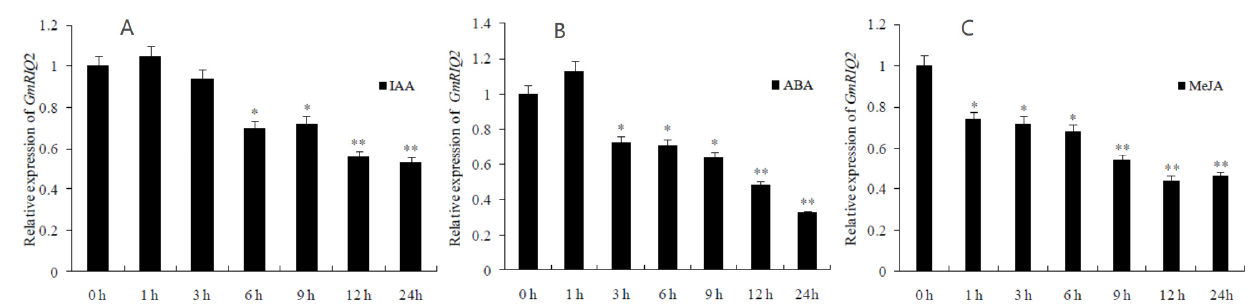
Figure 10. Determination of GUS activity of the transformed GmRIQ2 promoter ( PGmRIQ2 ) in Ara ‐ bidopsis under abiotic stress. ( A ) Drought: 250 mM mannitol; ( B ) salt: 200 mM NaCl; ( C ) high light: 300 μ mol/m 2 /s. The data are shown as the mean ± SE of three independent replicates. ** indicate significant difference at 0.01 levels. 3.5. Gene Expression of GmRIQ2 in Hormone ‐ Treated Soybean Soybean leaves were treated with hormones, and RNA was extracted from the leaves at different time points for fluorescence quantitative PCR analysis. The results showed that under the 50 μ M IAA or 100 μ M ABA treatment, the expression level of the GmRIQ2 gene increased slightly at first and then decreased significantly with increasing treatment